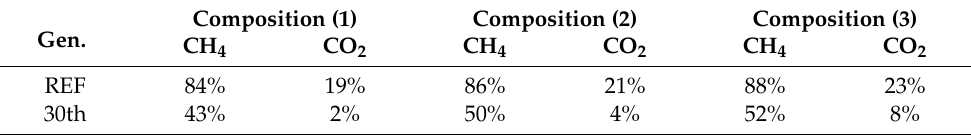
Table 6. Conversion of methane and carbon